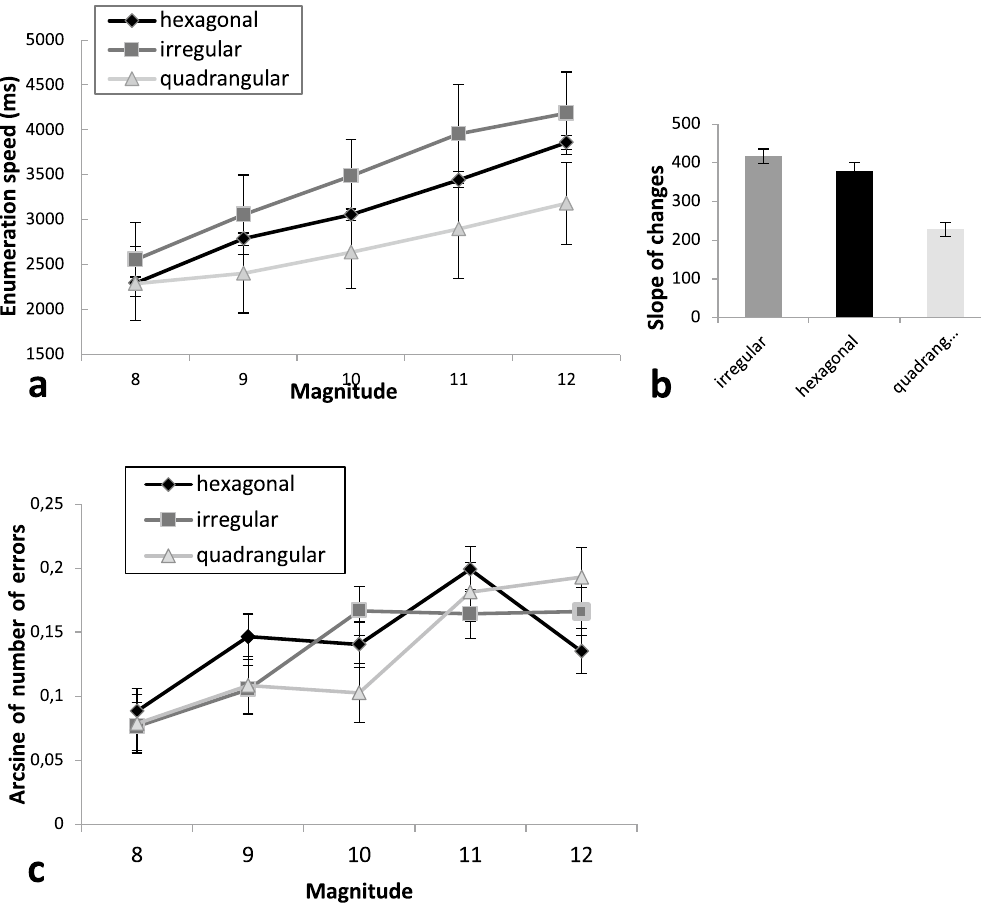
Figure 2. ( a ) Mean reaction times in three different arrangements. ( b ) Slope of reaction time changes by increased magnitude in three arrangements. ( c ) Interaction between magnitude and arrangement in error rates. All error bars depict 1 SE of